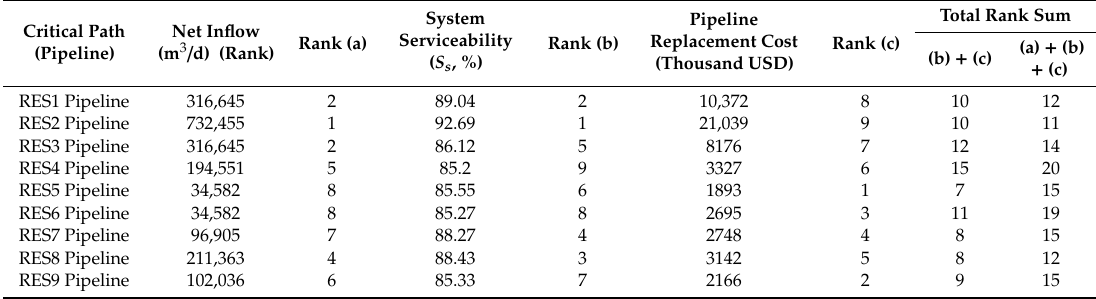
Figure 8. Relationship of System Serviceability ( S s ), Cost of Earthquake Resistance, and Supply in Each Critical Path. Table 5. Comprehensive Assessment of System Serviceability ( S s ), Cost of Earthquake Resistance, and